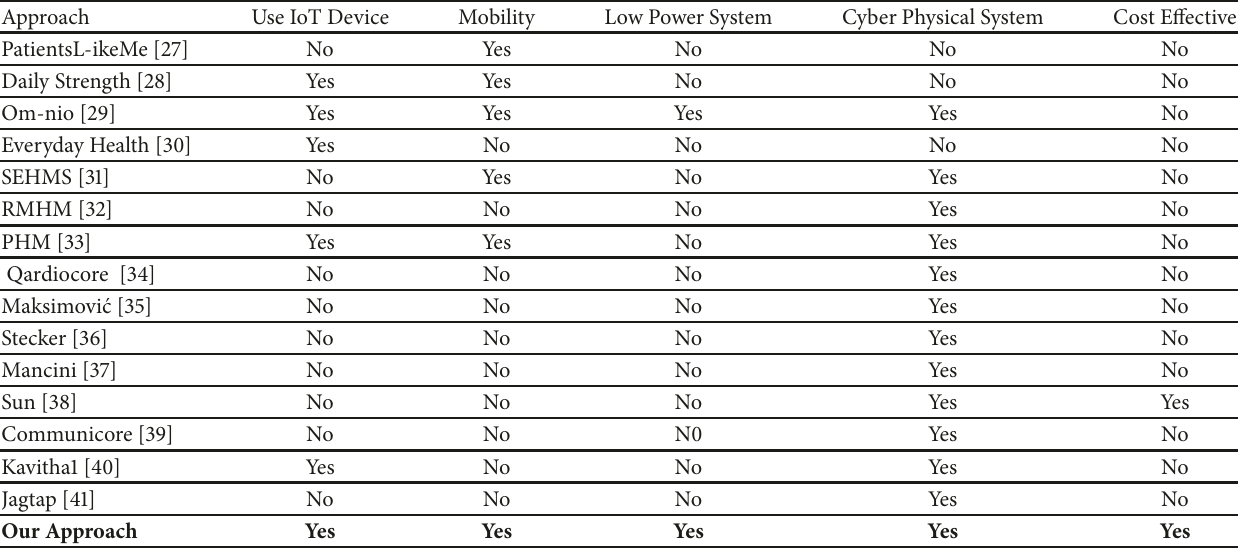
Table 1: Qualitative comparison of existing work based on different features.